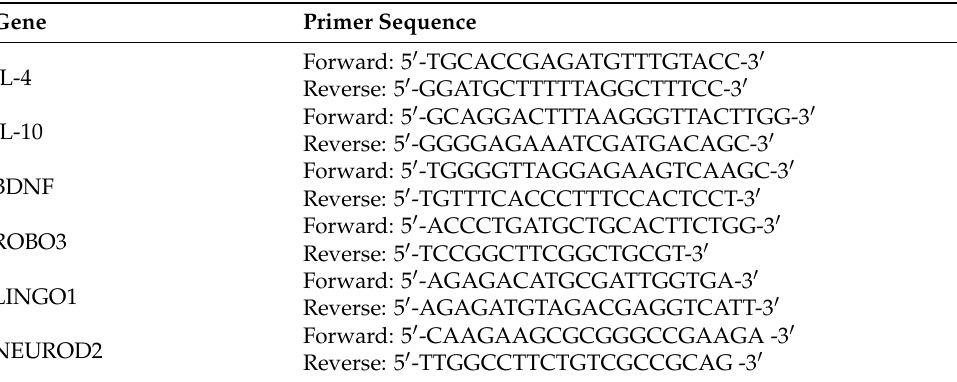
Table 3. Genes and primer sequences used for